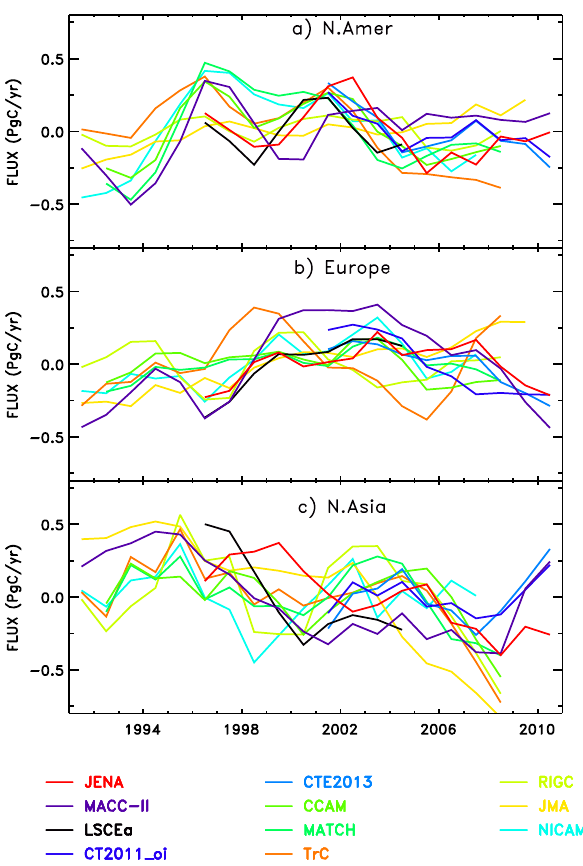
Fig. 8. Same as Fig. 7 but with a breakdown of the northern land fluxes into (a) North America, (b) Europe, and (c) North Asia.